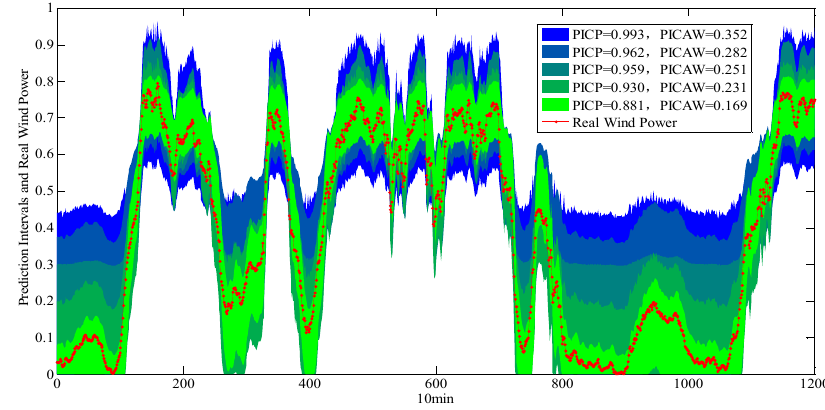
Figure 4. Prediction intervals with CWC ABC-based when η = 50. CWC: coverage width-based criterion; ABC: artificial bee colony; PICAW: PIs covered-normalized average width; PICP: PI coverage probability.